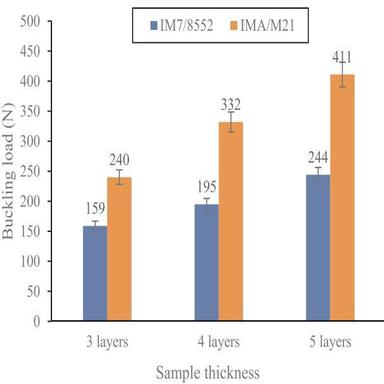
Influence of the sample thickness on the measured buckling load. (For interpretation of the references to colour in this figure legend, the reader is referred to the web version of this article.)